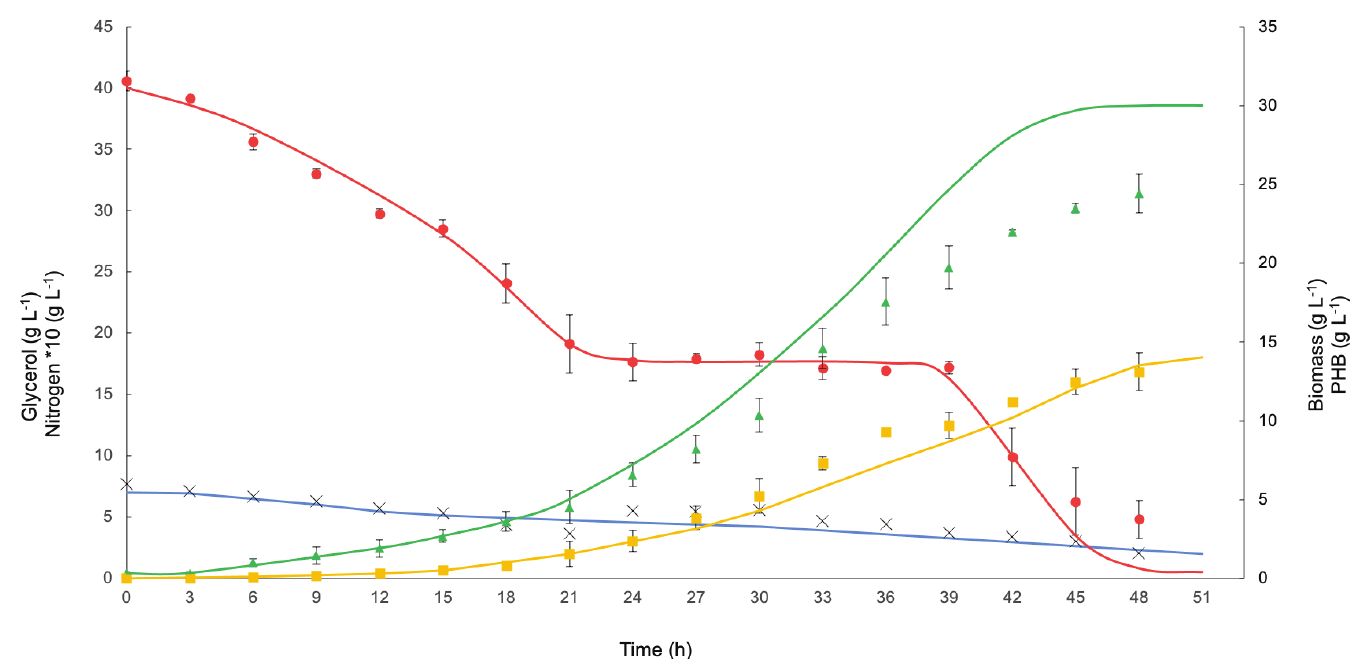
Fig. 6 – Model-based fed-batch cultivation involving constant availability of substrate. Data points represent experimental values, and smooth lines indicate model predictions. 0–20 h batch cultivation, 20–40 h – fed-batch cultivation, 40–48 h – second- ary batch cultivation. Data points (● Glycerol, × Nitrogen, ■ PHB, ▲ Biomass) represent the average values of the sam - ples